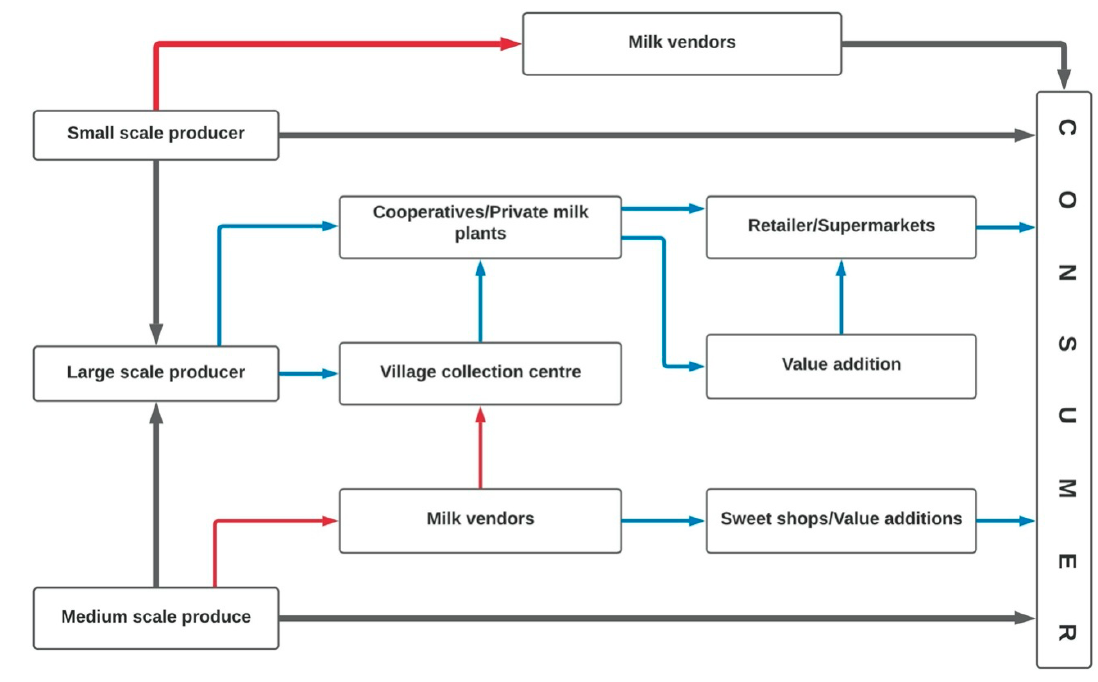
Figure 3. Flow diagram of the output chain of milk through various marketing channels as created during the study of dairy value chain in Punjab, India during 2018–2019. Blue and red color arrows indicate low and high risk of disease transmission, respectively.